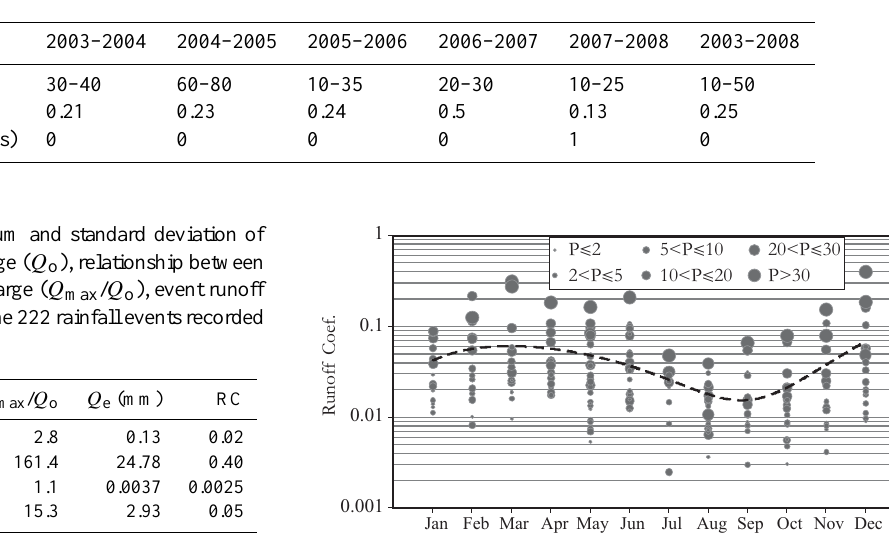
Table 2. Hydrologic parameters obtained from time series analyses of daily precipitation and discharge registered in Aixola station from 2003 to 2008. The memory effect is the value of k for r = 0 . 1–0.2 in the discharge correlogram, the spectral band is the frequency from which the simple spectrum of discharge is negligible ( S f < 1) and the quickness of the response is the value of k for the maximum value of the cross-correlogram.